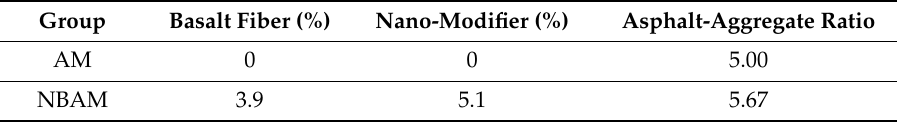
Table 6. Preparation parameter of asphalt mixture specimens.